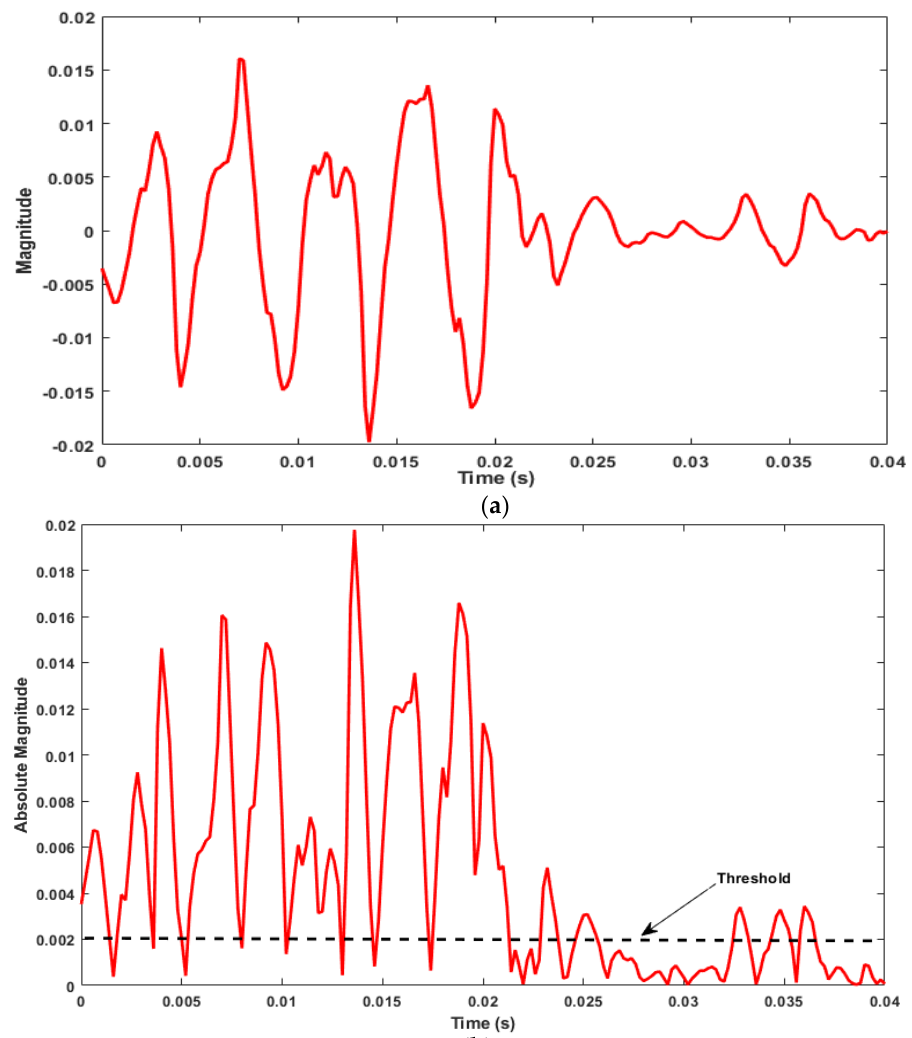
Figure 10. Energy wavelet for combined reconstructed coefficient ( a ) and absolute value ( b ).